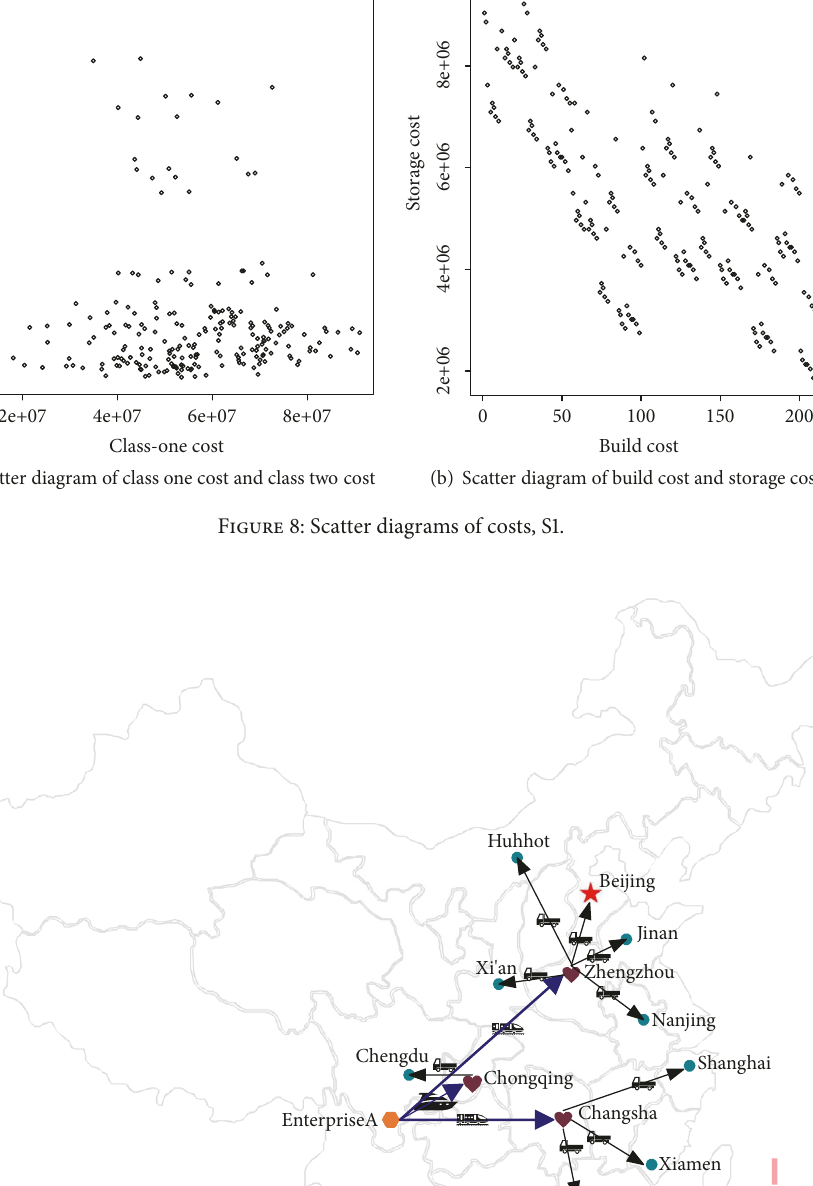
Polyakovskiy’s model and the model suggested in this